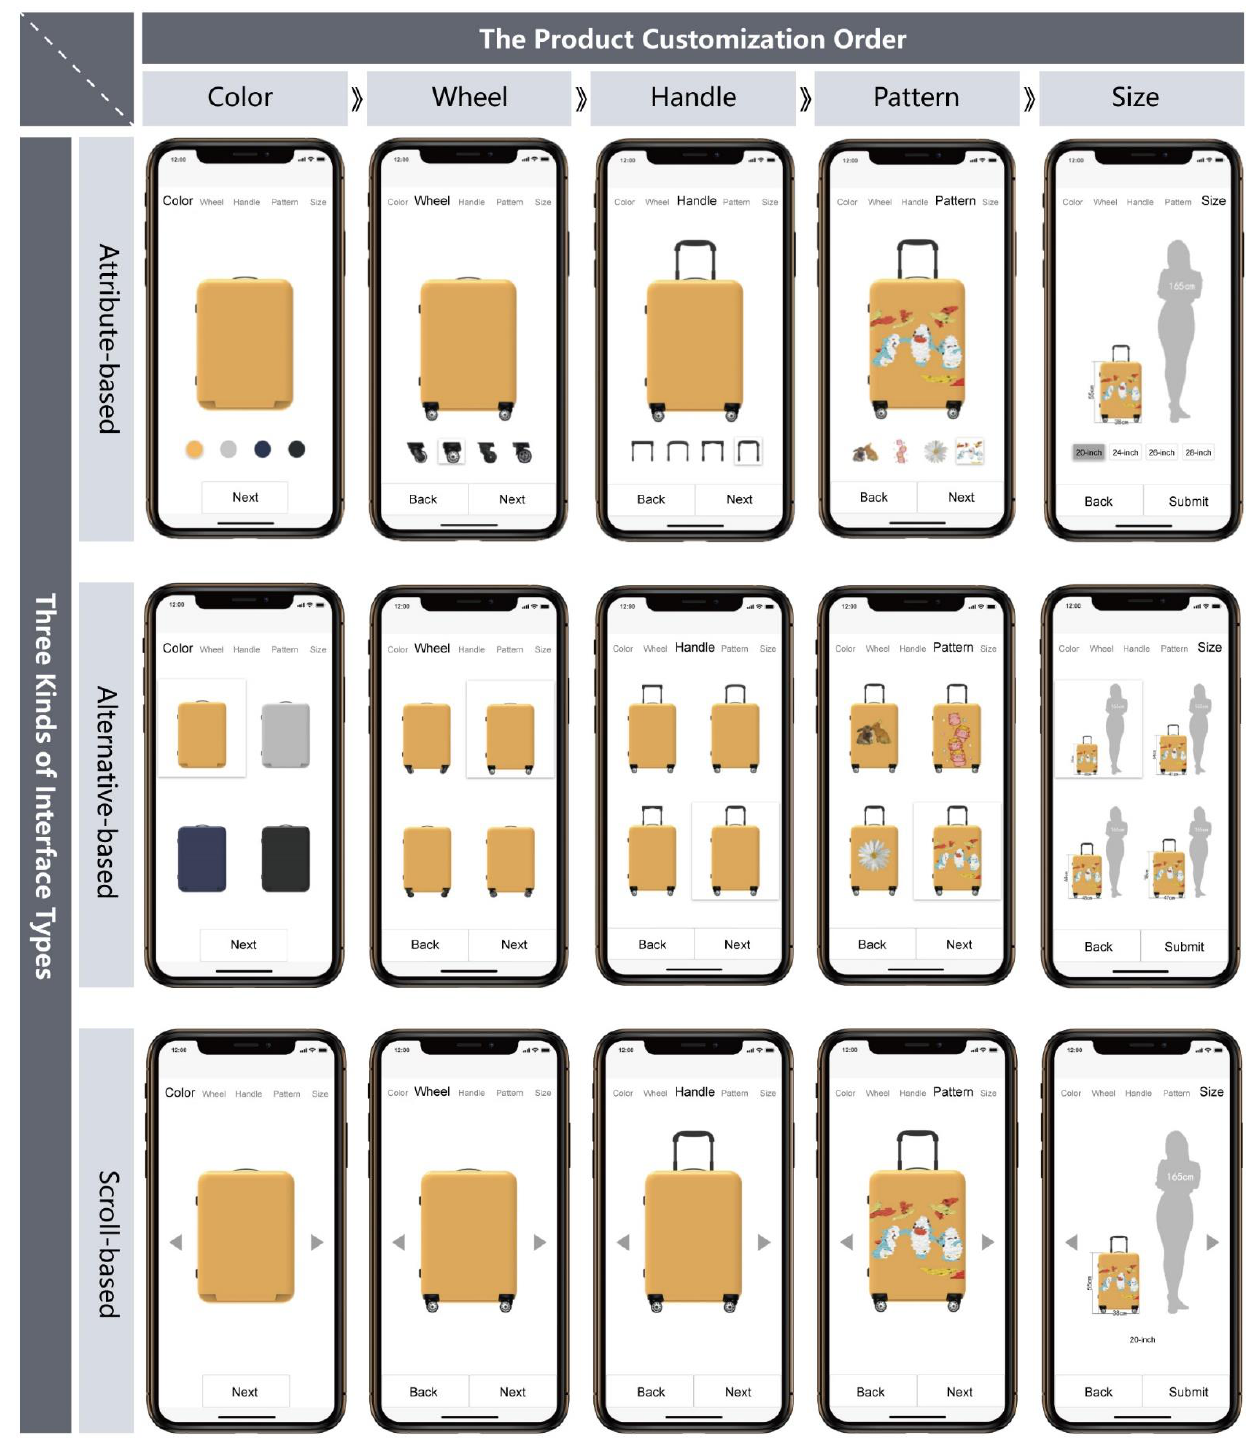
Figure 4. Three different interface designs and product customization steps adopted in the experiment.